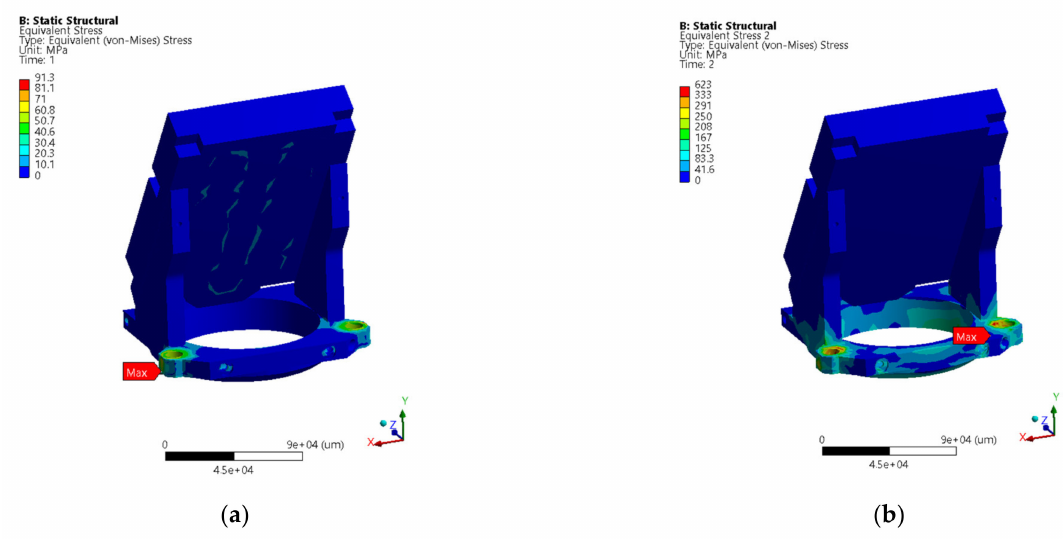
Figure 12. ( a ) Equivalent von Mises stress for primary load. ( b ) Equivalent von Mises stress for secondary